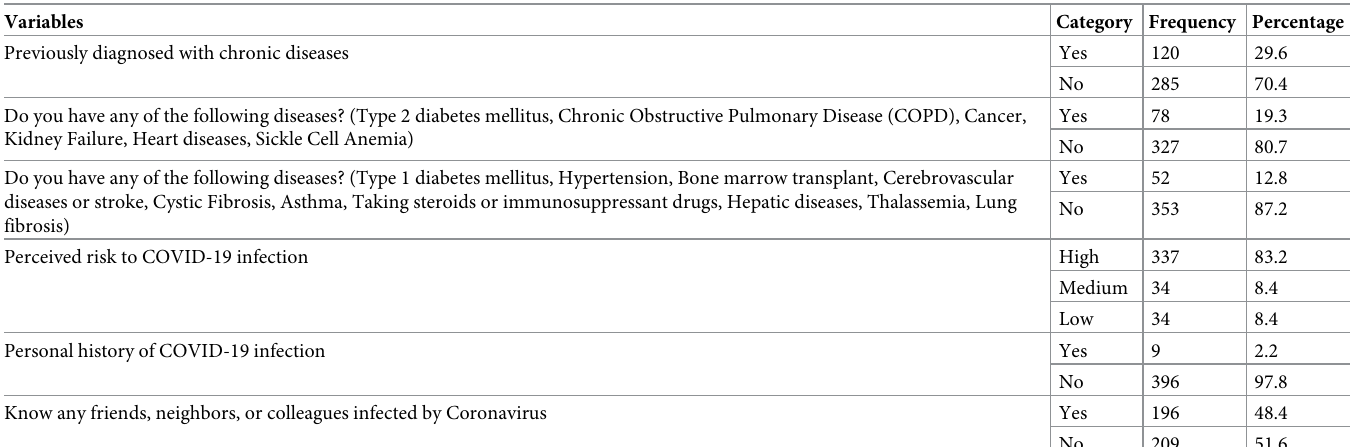
Table 2. Health status and COVID-19 experience of health the professionals working at hospitals of southwestern Ethiopia, 2021 (n = 405).